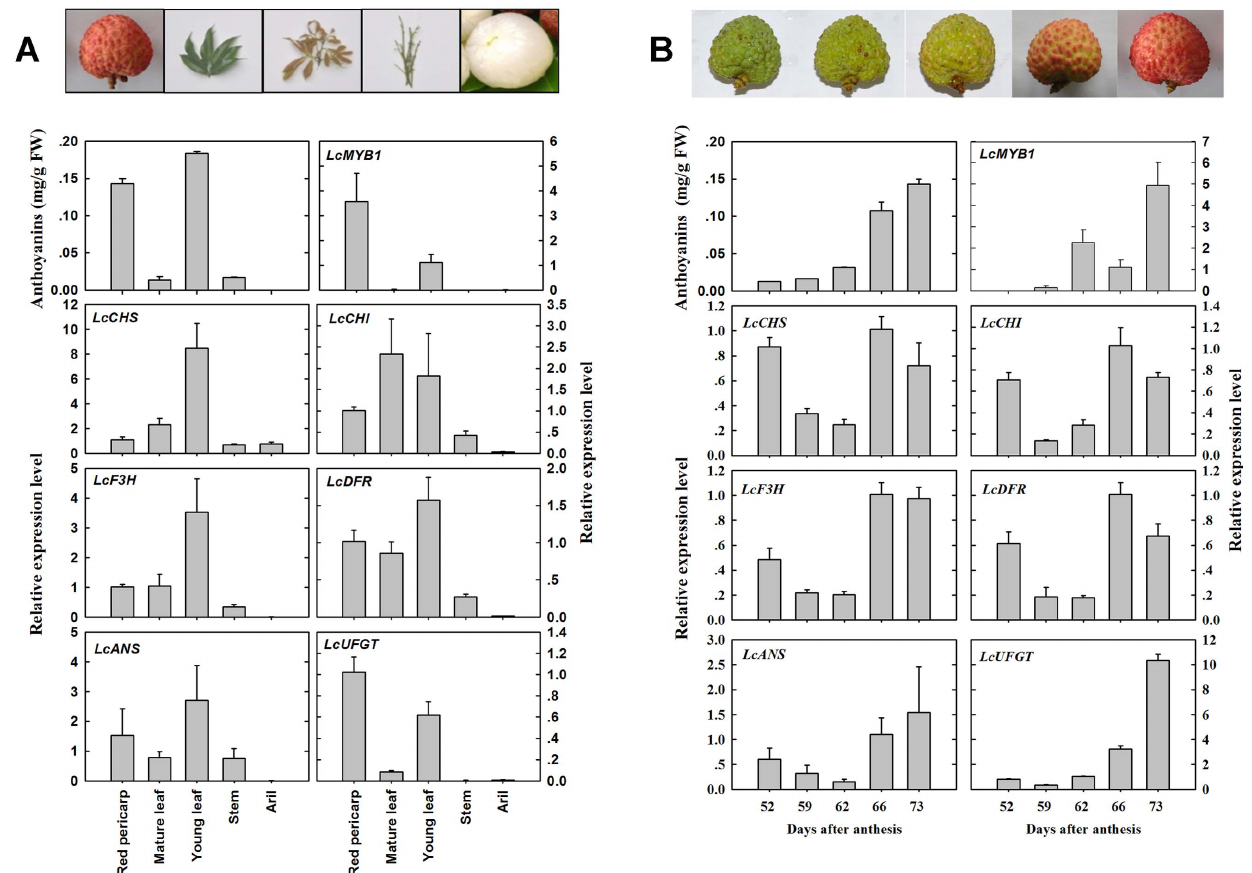
Figure 3. Anthocyanin contents and expressions of biosynthetic genes. (A) Anthocyanin contents and expression analysis of LcMYB1 and anthocyanin biosynthetic structural genes in different tissues of ‘NMC’ litchi including red pericarp, mature and young leaves, young stem and aril. (B) Anthocyanin contents and expression analysis of LcMYB1 and anthocyanin biosynthetic structural genes in the pericarp of ‘NMC’ litchi during fruit development. The Lcactin gene was used to normalize the expression levels of the genes under identical conditions. The vertical bars represent the standard error of triplicate experiments.